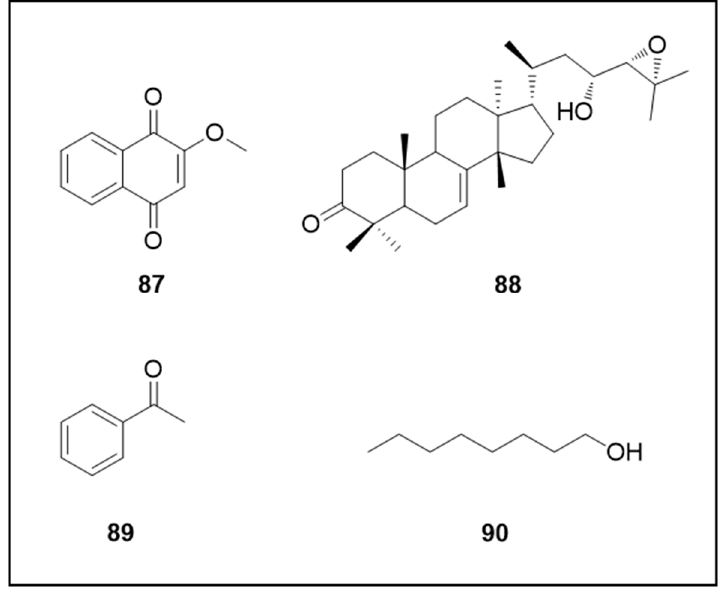
Figure 14. Naphthoquinone, protolimonoid, alcohol and ketone with activity against Ae. aegypti .